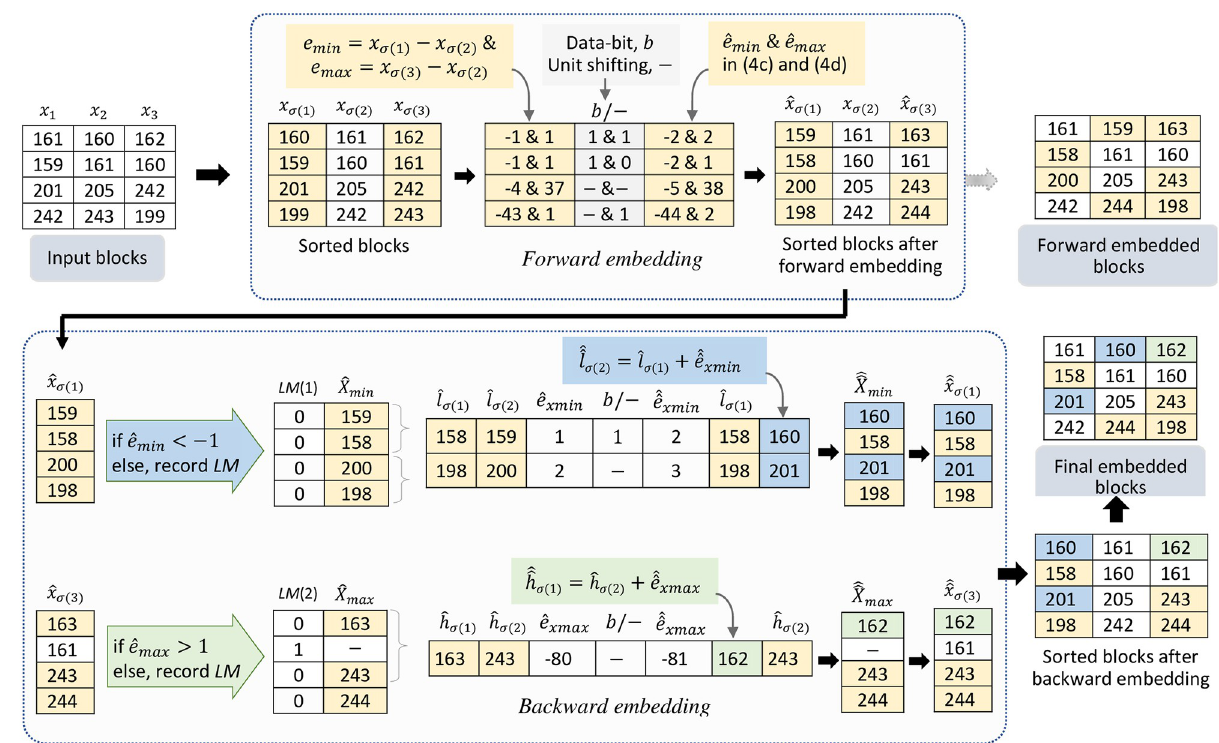
Fig 2. Example of the forward and backward embedding (the yellow cells represent the pixels and their changes in forward embedding, and the blue and green cells represent the pixels and their changes in backward